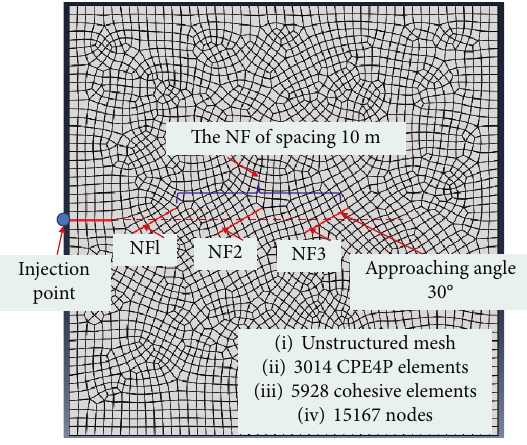
Figure 8: Physical model of three NFs intersected with one HF, where CPE4P elements represent a quadrilateral element with pore pressure.